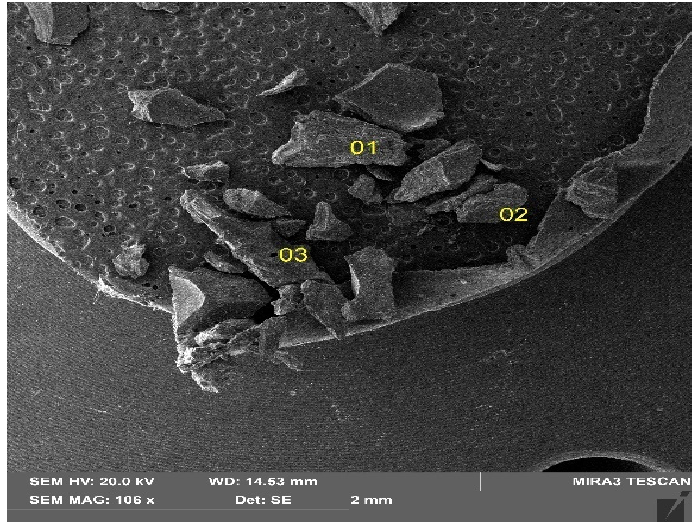
Energies 2023 , 16 , x FOR PEER REVIEW Figure 6. Fragments of the coal recyclate under analysis SEM image. Figure 6. Fragments of the coal recyclate under analysis SEM image.